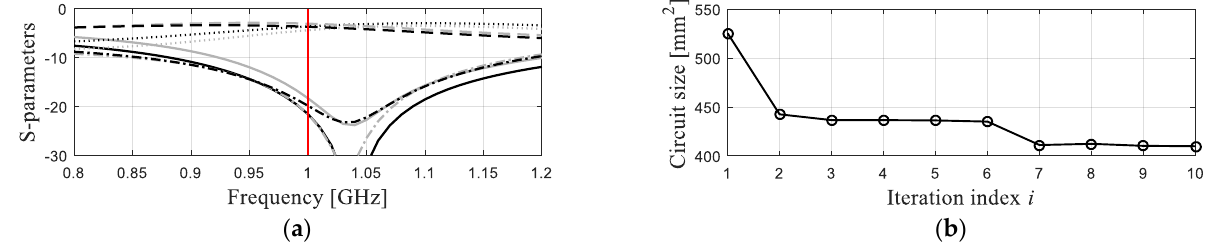
Figure 6. Circuit III: ( a ) responses at the initial ( A 0 = 525 mm 2 ) and design optimized using the proposed algorithm (reduced size: A opt = 409 mm 2 ), indicated using gray and black, respectively; S -parameters marked as | S 11 | (—), | S 21 | ( ···· ), | S 31 | (- - -), | S 41 | (- .); the vertical line marks the circuit operating frequency; ( b ) evolution of the circuit size throughout the optimization run.